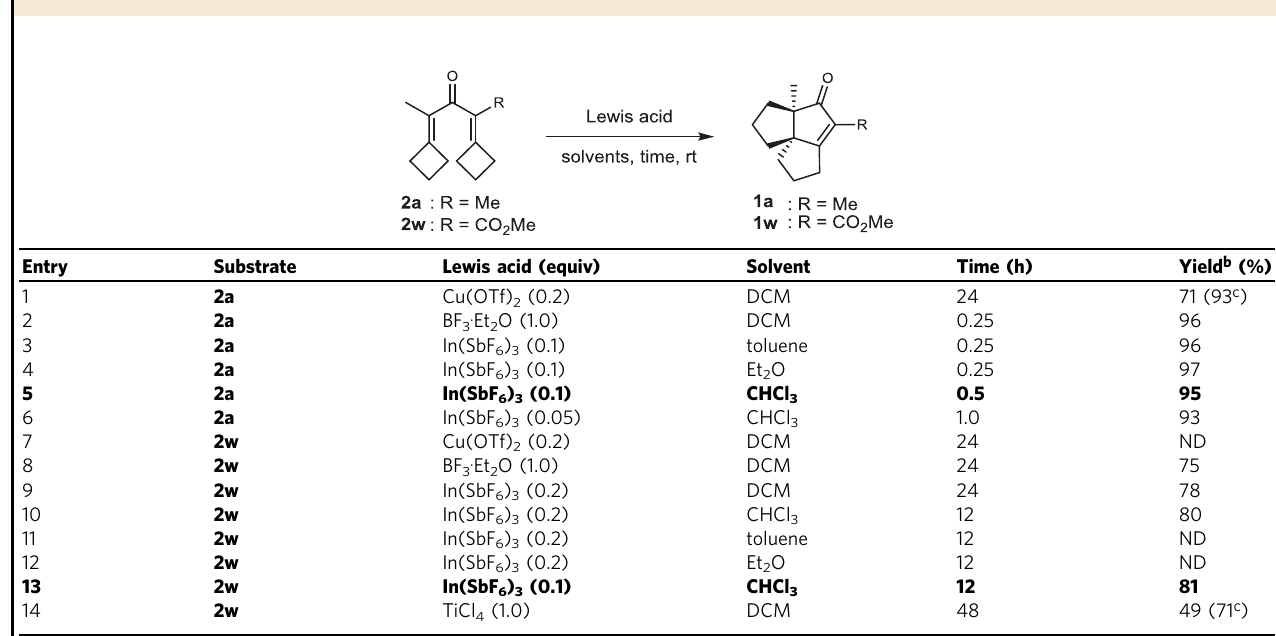
Table 1 Optimization of reaction conditions and catalysts a,d